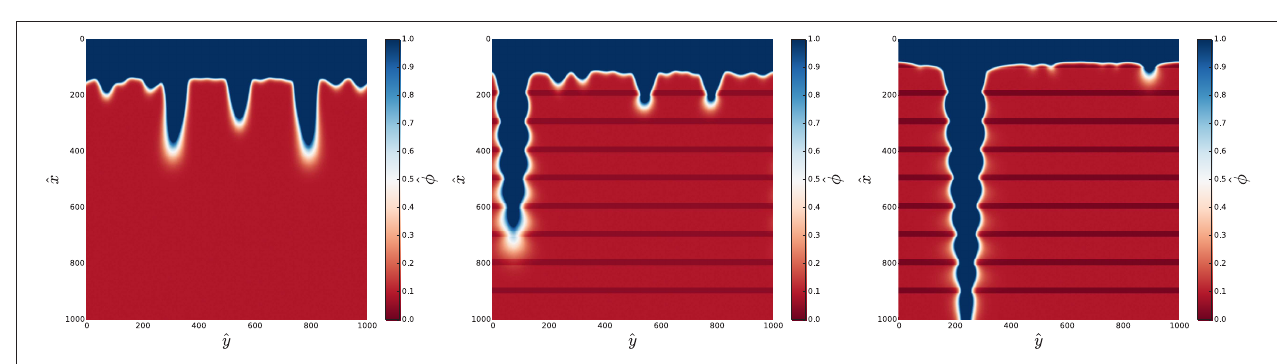
FIGURE 16 | Piping patterns for C = 1 (no layers, left), C = 2 (center), and C = 4 (right) for Pe = 1 , Da = 0.1 and κ = 5 .